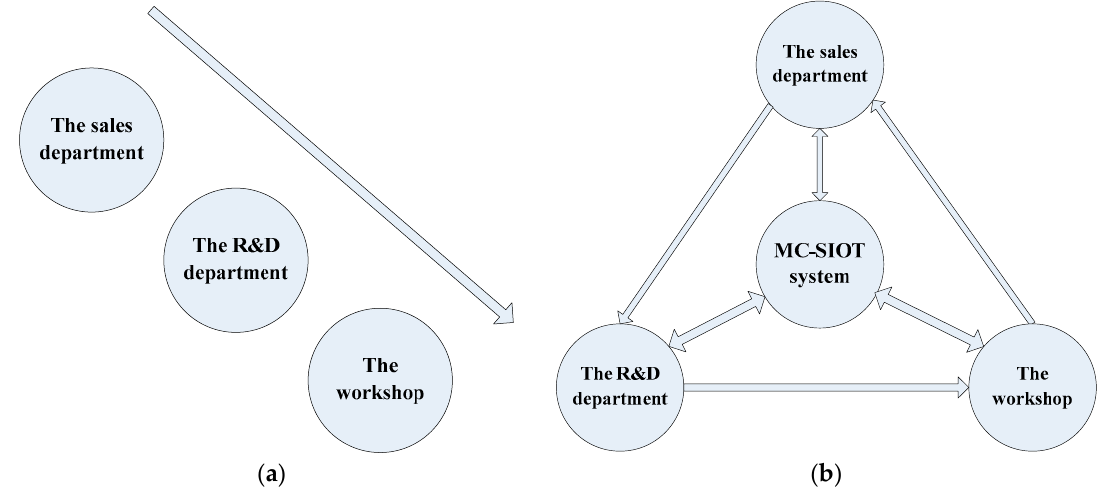
Figure 2. ( a ) Traditional MC system. ( b ) MC–SIOT system.